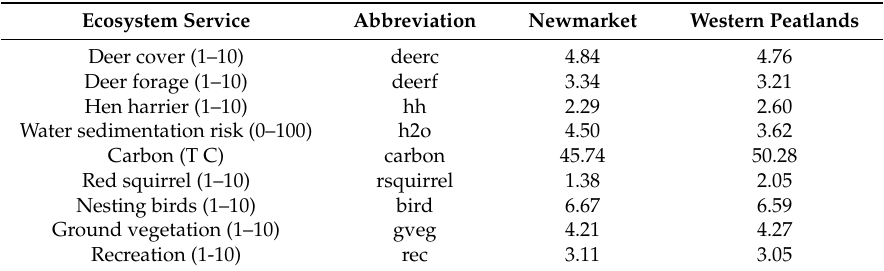
Table 4. The ecosystem service provisions for both Case study areas at the start of the year 2012, on a per hectare basis.